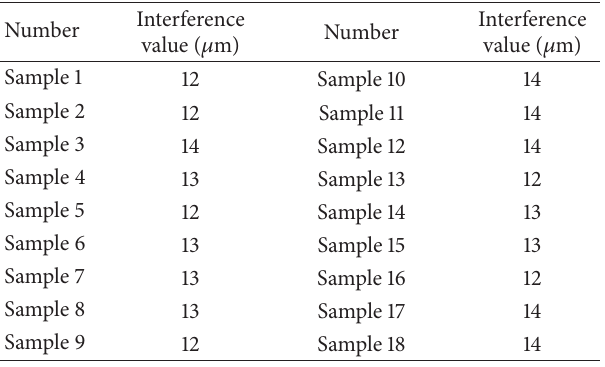
Table 6: Maximum press-mounting forces obtained from experi- ments.